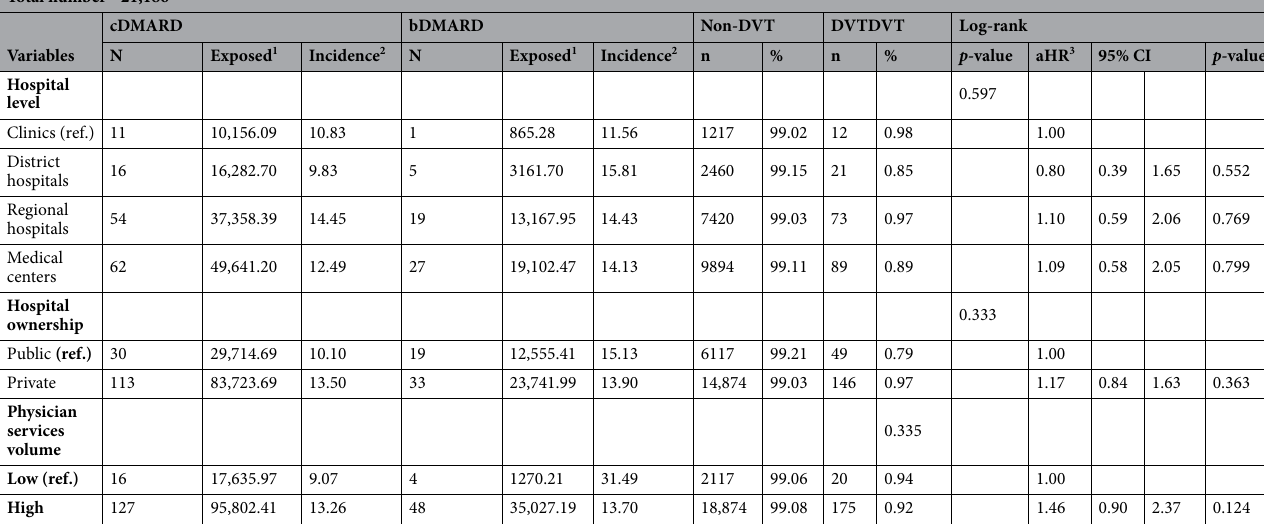
Table 3. Risk and related factors of VTE in match RA patients using different DMARDs. N = number, y = years, sd = standard deviation, NT dollars = New Taiwan dollars. The unit of Exposed is person-years.